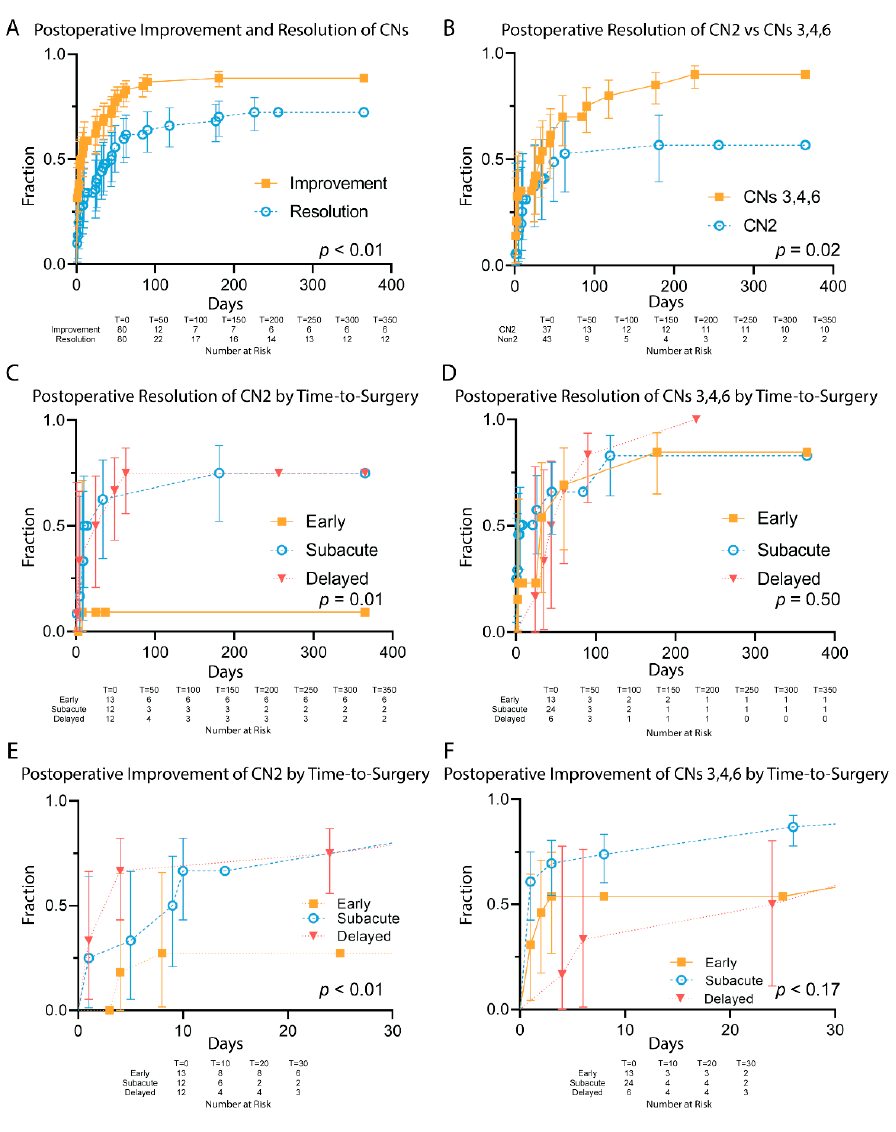
Figure 2. Postoperative Resolution and Improvement of Cranial Nerve Deficits. ( A )—Postoperative Improvement and Resolution of CNDs. ( B )—Resolution of CN2 vs CNs 3, 4, and 6. ( C )—Resolution of CN2 by time-to-surgery cohort. ( D )—Resolution of CNs 3, 4, and 6 by time-to-surgery cohort. ( E )—Improvement in CN2 by time-to-surgery cohort. ( F )—Improvement in CNs 3, 4, and 6 by time-to-surgery